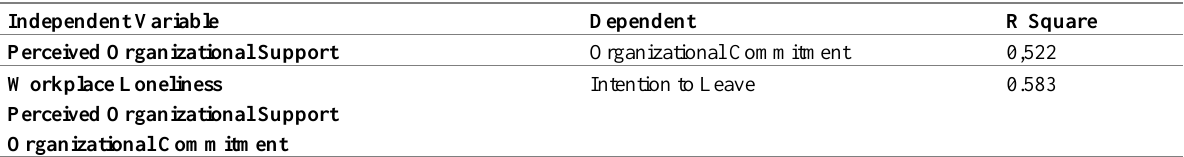
Table 5: Result of R-Square